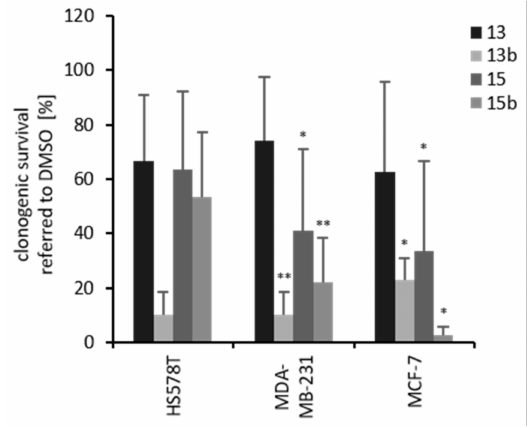
Figure 5. Clonogenic survival of breast cancer cells. Breast cancer cells were incubated with betulin derivatives (20 µ M) under hypoxia (0.1% O 2 ) for 24 h. The diagram shows clonogenic survival [%] relative to DMSO-treated cells for each breast cancer cell line. Data represent mean values (+SD) of at least three independent experiments. Significant p values (differences of treated cells compared to DMSO) are highlighted with asterisks (* p ≤ 0.05, ** p ≤ 0.01).